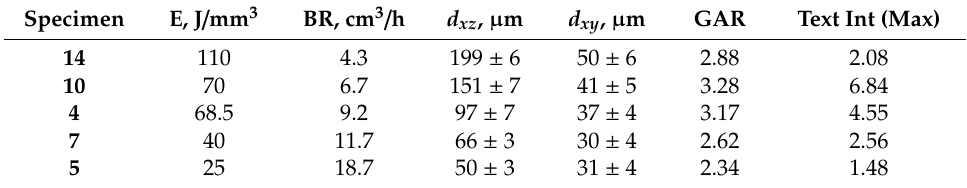
Table 6. Measured and calculated density, grain size and grain aspect ratio, and their deviations.